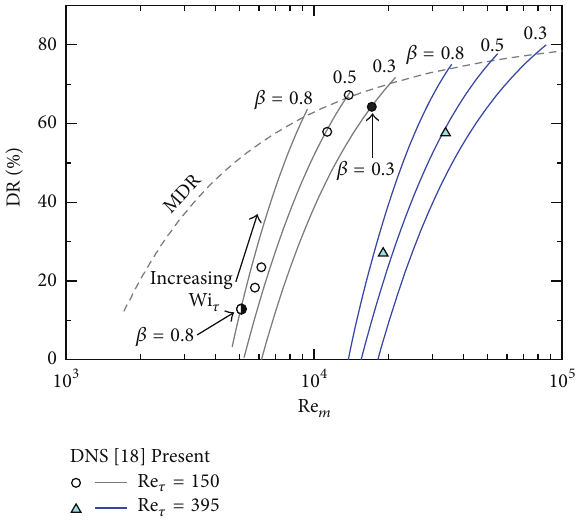
Figure 8: Drag reduction rate.